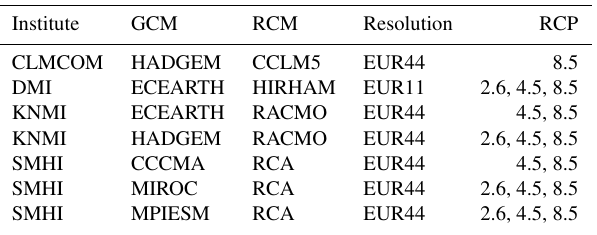
Table 4. Details about the considered climate models. GCM: global climate model. RCM: regional climate model. RCP: representative concentration